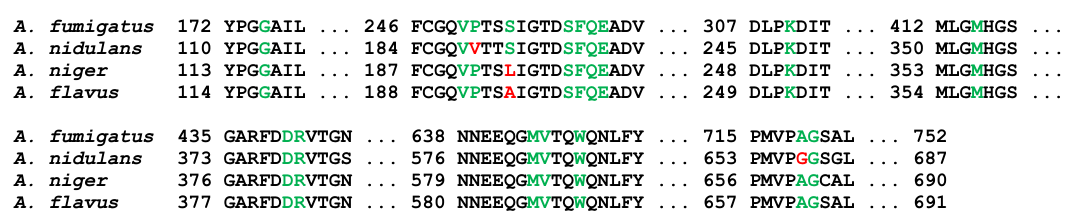
A. fumigatus 435 GARFDDRVTGN ... 638 NNEEQGMVTQWQNLFY ... 715 PMVPAGSAL ... 752 A. nidulans